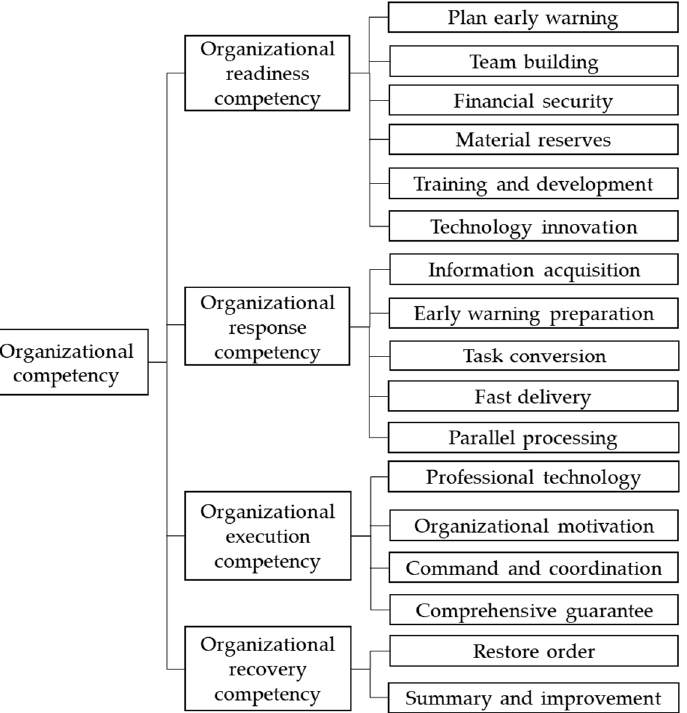
Figure 1. First-level and second-level assessment indicators of full-time water conservancy emergency rescue teams.